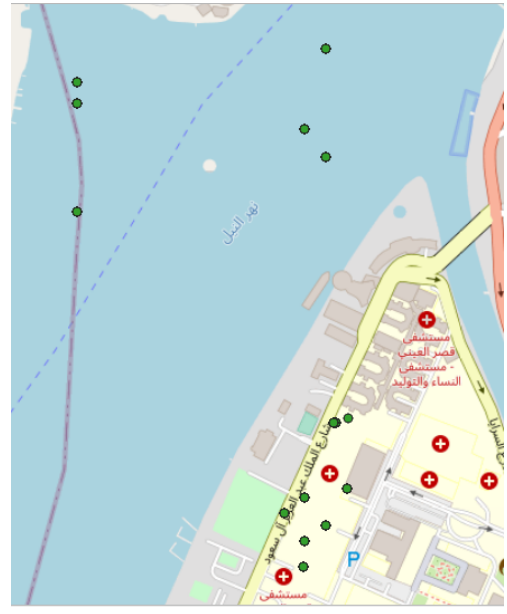
Figure 13. Representation of the cluster found as part of the event (5 tracks, 9418 points) in Cairo (Egypt) in August 2018 [47]. Note that 6309 points are affected by low GPS accuracy due to the measurement inside a building, which makes them poorly positioned on the Nile River; represented area of approximately 950 m × 820 m. All the data are extracted from the NoiseCapture database